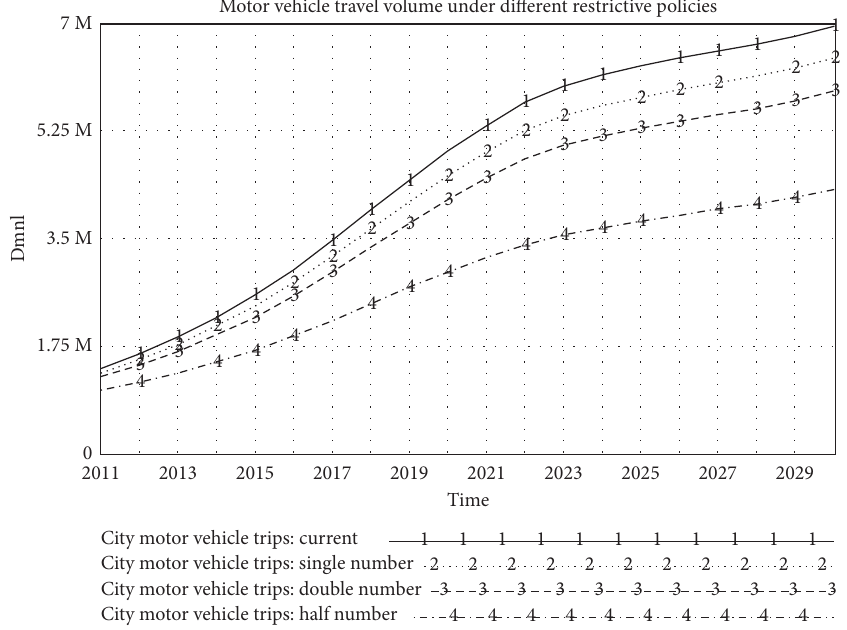
Figure 9: Vehicle traffic in cities under different restrictions. Table 5: Comparison of the number of private cars with and without implementation of the private car purchase restriction